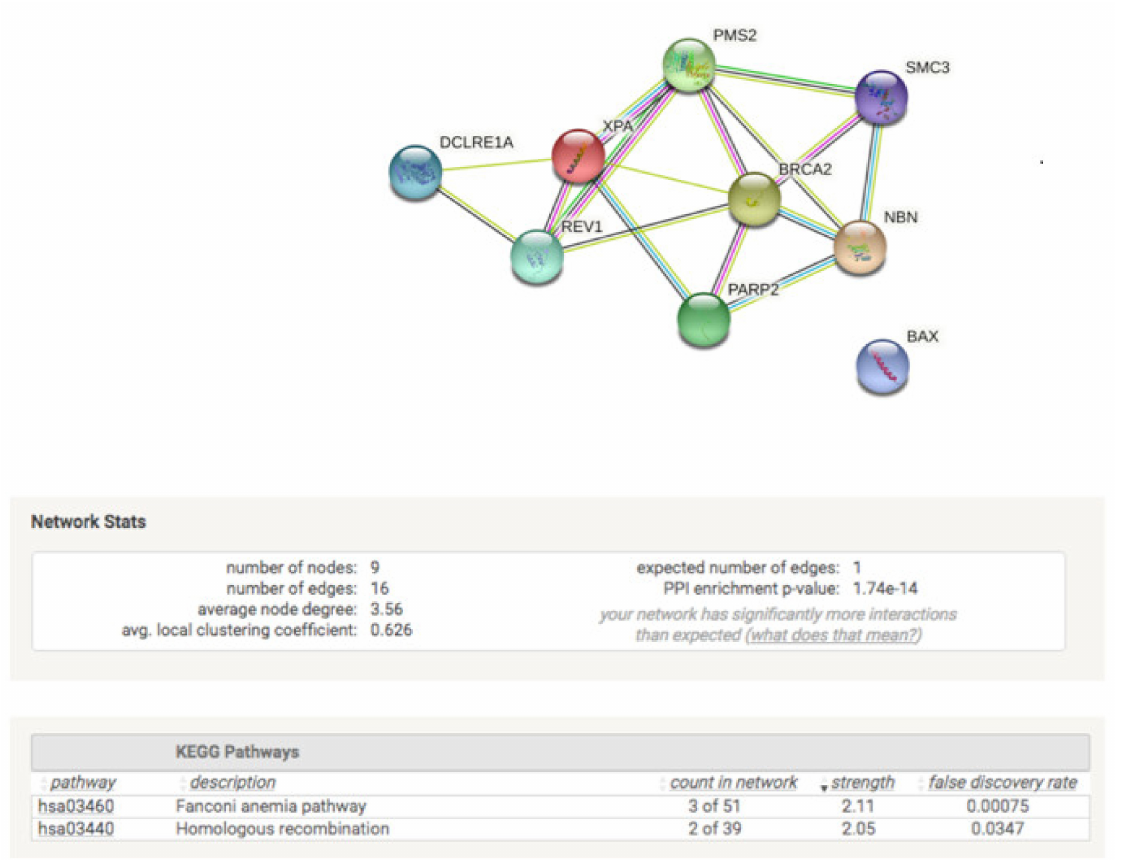
Figure 5. Protein interaction analysis. Differential study of protein interactions of DNA repair genes between cells that overexpress miR27b-3p treated with doxorubicin and genes that are not expressed in BALB/c-3T3 cells treated with doxorubicin. STRING analysis (v11.5) was performed using fold shift expression values